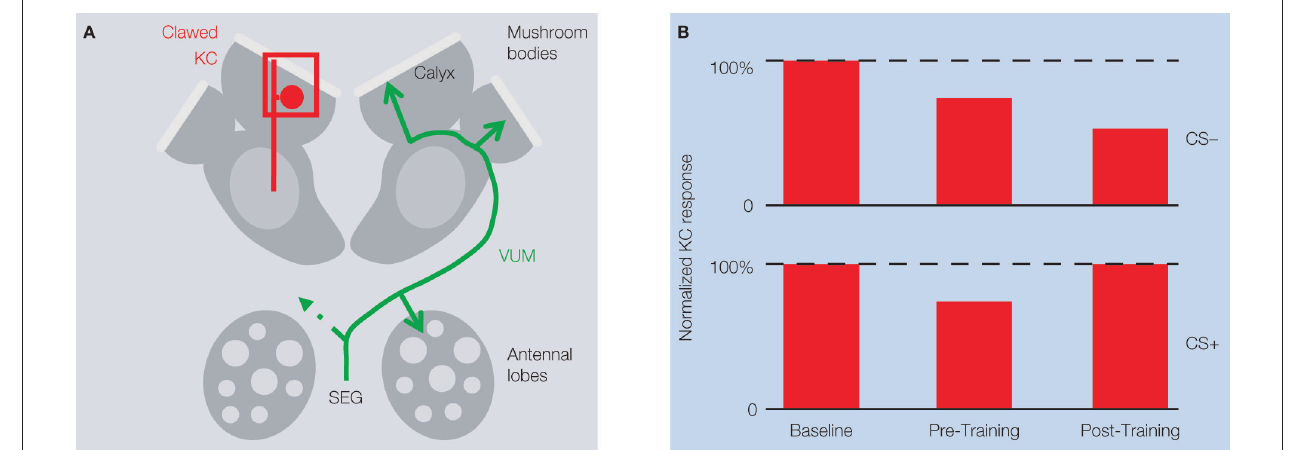
subesophageal ganglion (SEG) with the antennal lobes and the MB calyces, mediates the reinforcing function of the reward. (B) Amplitude of KC responses to the rewarded odor (CS+) and to the unrewarded odor (CS−) before training, after repeated odor stimulation with both odors (pre-training), and after pairing CS+ with sucrose